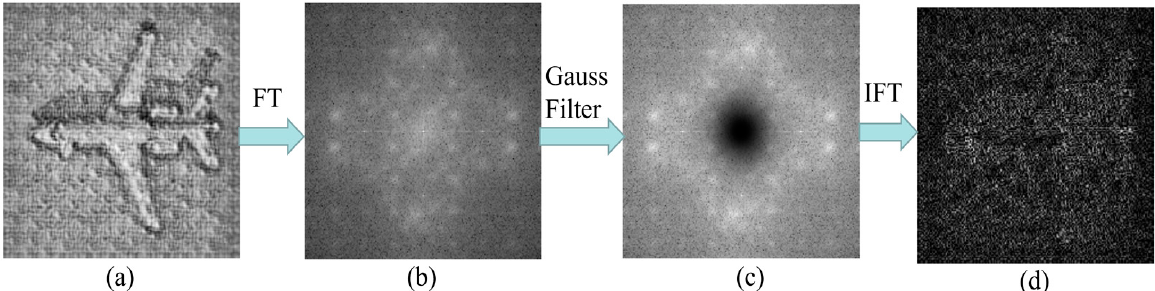
Figure 9. Frequency analysis on style transfer sample image. ( a ) Gray image using style transfer directly. ( b ) Fourier transform on sonar image. ( c ) Gaussian filter frequency in frequency image. ( d ) Gaussian filtered image.